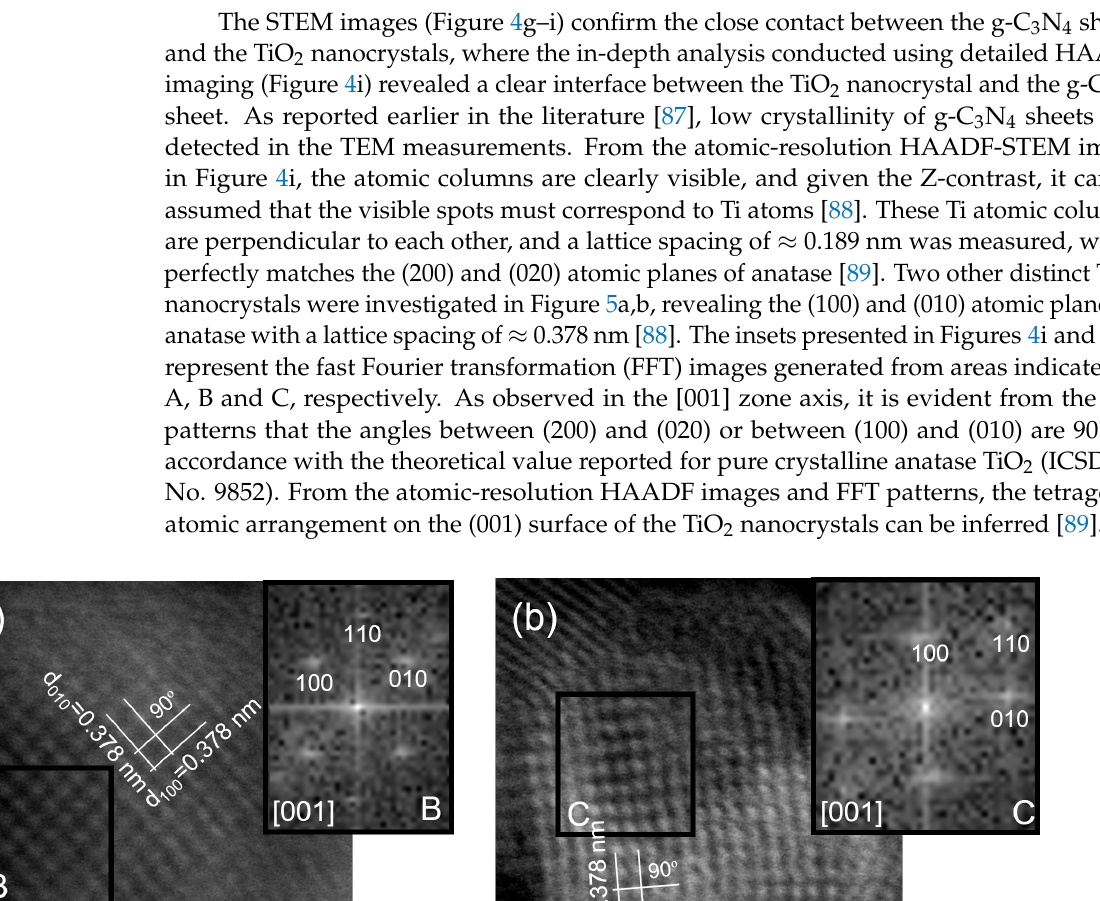
Figure 6 . Artificially colored (mixed) SE-STEM image of the 30-GCN-T material ( a ), together with the corresponding EDS maps of C ( b ), N ( c ), O ( d ) and Ti ( e ). 3.1.3. AFM AFM measurements were performed to determine the average height/thickness of the produced g-C 3 N 4 nanosheets. The average thickness of g-C 3 N 4 nanosheets was calcu- lated based on several scans, which were taken from AFM images, and the value was